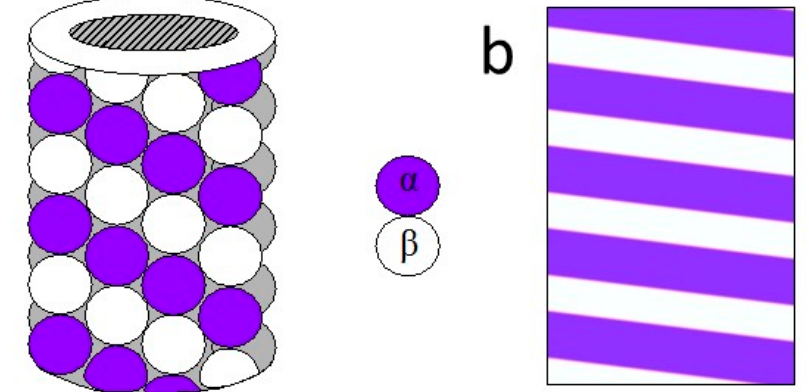
Figure 1. ( a ) Sketch of a microtubule. ( b ) Simple drawing of a single photonic crystal layered with 18° tilt.